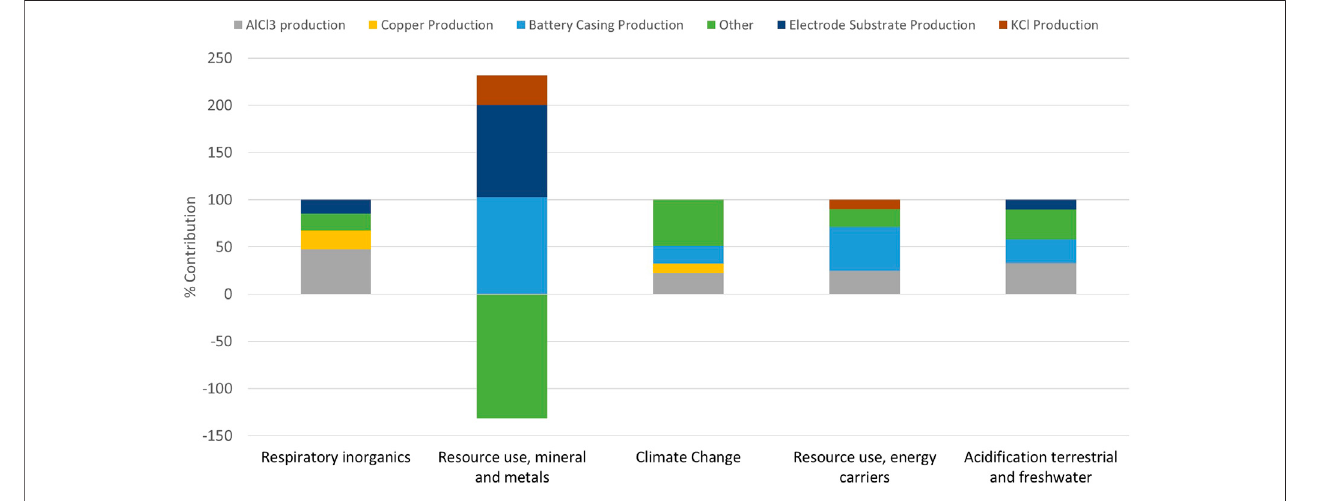
FIGURE 8 | Top fi ve impact categories with their main